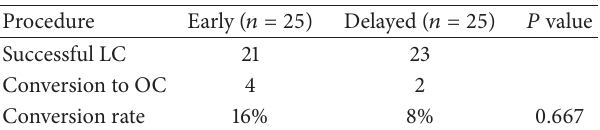
Table 3: Comparison of conversion to open cholecystectomy in early and delayed